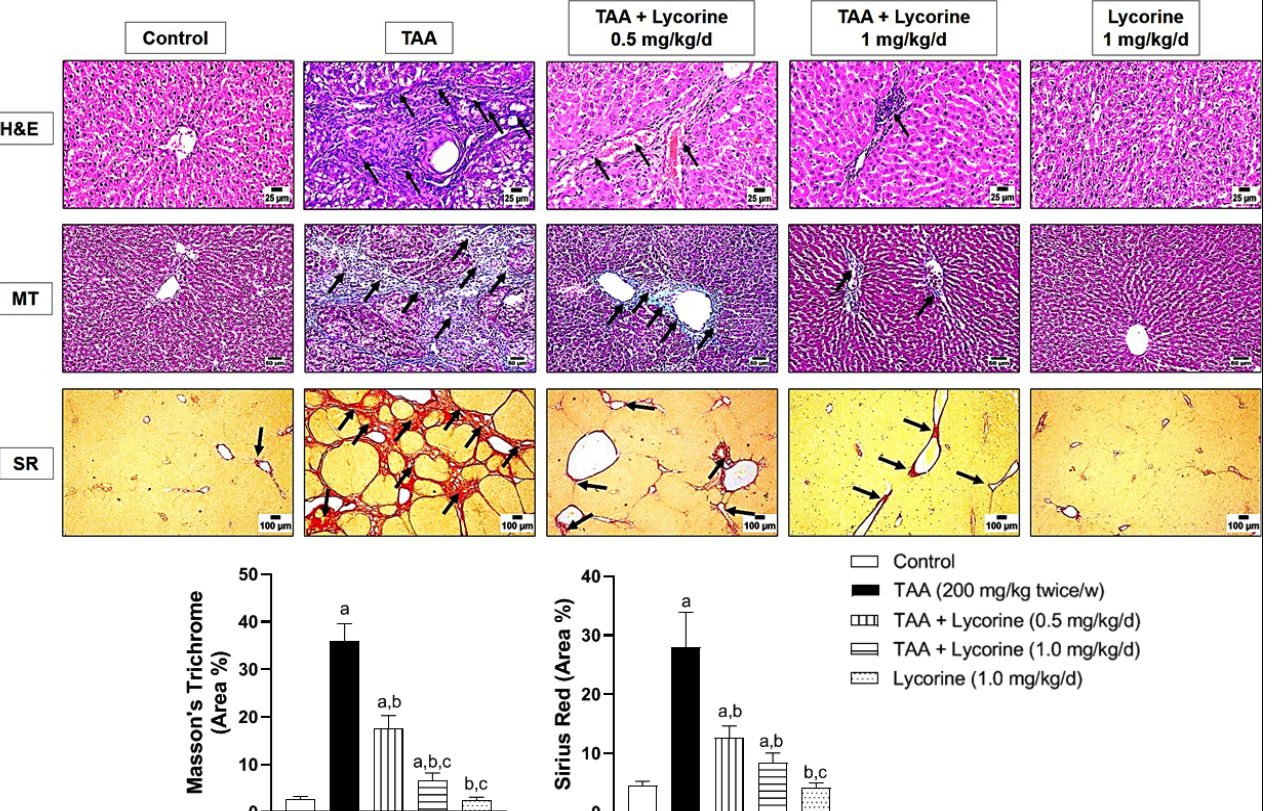
Figure 2. Histopathological examination of liver sections stained by hematoxylin and eosin (H&E), Masson’s Trichrome (MT) and Sirius Red (SR) in a rat model of thioacetamide (TAA)-induced liver fibrosis. The control group shows a normal lobular architecture (H&E), accompanied by a normal distribution of fine collagen fibers around the central vein (MT and SR); the TAA-exposed group displays thick fibrous strands that surrounds the hepatic lobules with mononuclear inflammatory cell infiltration (arrows) and hepatocellular vacuolar degeneration (H&E), accompanied by abundant fibroplasia completely surrounding the hepatic lobules (blue with MT and red with SR); treatment with lycorine (0.5 mg/kg/d) shows a moderate improvement of the histopathological changes by all stains; treatment with lycorine (1 mg/kg/d) shows a marked improvement of histopathological changes, except for minor inflammatory cells infiltration (H&E) together with fine collagen deposition (MT & SR), as indicated by arrows; the lycorine-alone group (1 mg/kg/d) displays apparently normal hepatic tissue (H&E) and collagen deposition (MT and SR). MT and SR staining was quantified as (area %). Data are presented as mean ± S.D. ( n = 6). (a), (b), (c) Statistically significant from the control, TAA, and TAA + lycorine 0.5 mg/kg/d groups, respectively, at p < 0.05 using one-way analysis of variance (ANOVA) followed by Tukey’s as a post- hoc